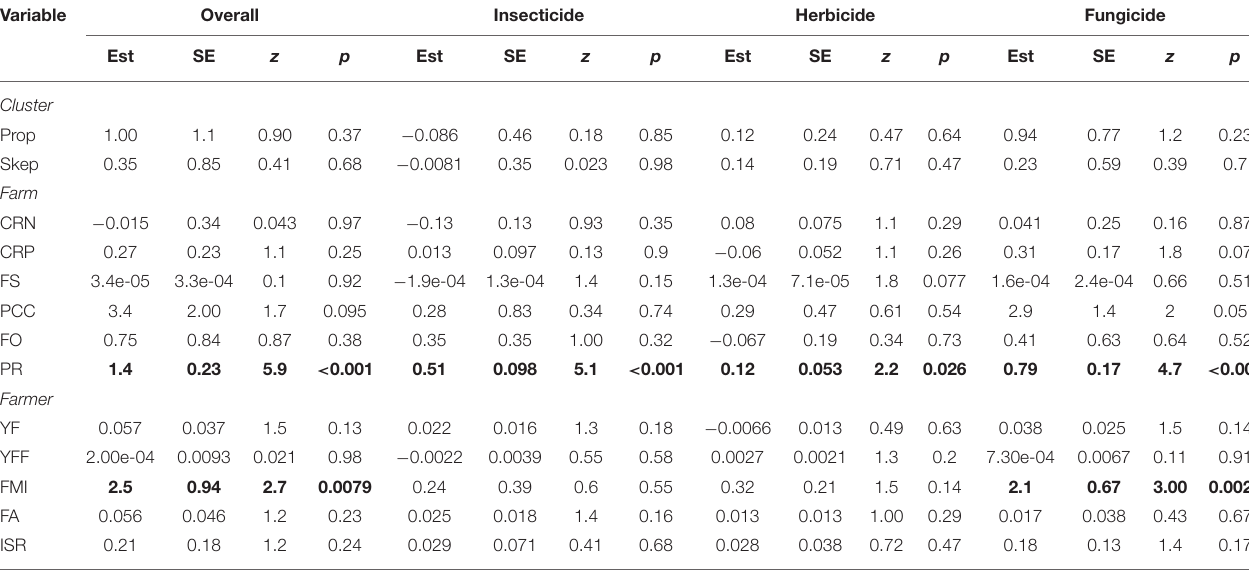
TABLE 3 | Model averaged parameter estimates, standard errors, z -, and p -values for the relationship between pesticide use and explanatory variables (rows). Variable Overall Insecticide